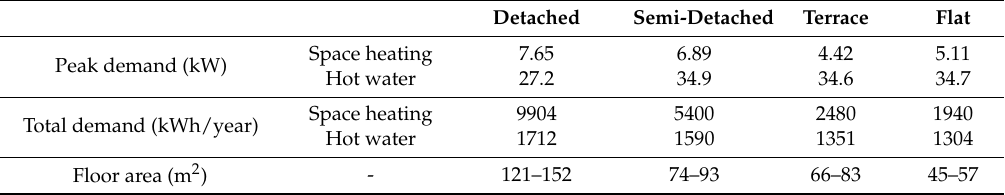
Table 1. Energy demand and house